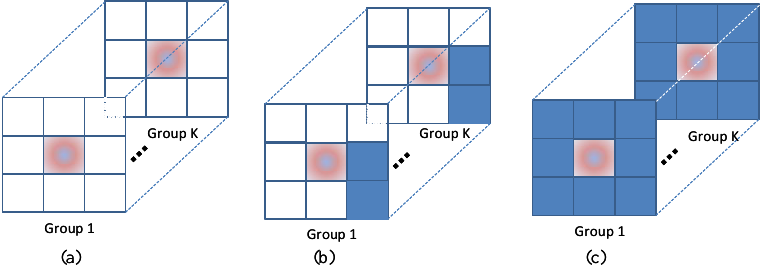
Figure 2. Three clustered patterns for the 2-D image. ( a ) Pattern 0: a strong rejection example with κ l = 0 ; ( b ) Pattern 1: a weak rejection example with κ l = 1 case; ( c ) Pattern 2: a strong acceptance example with κ l =